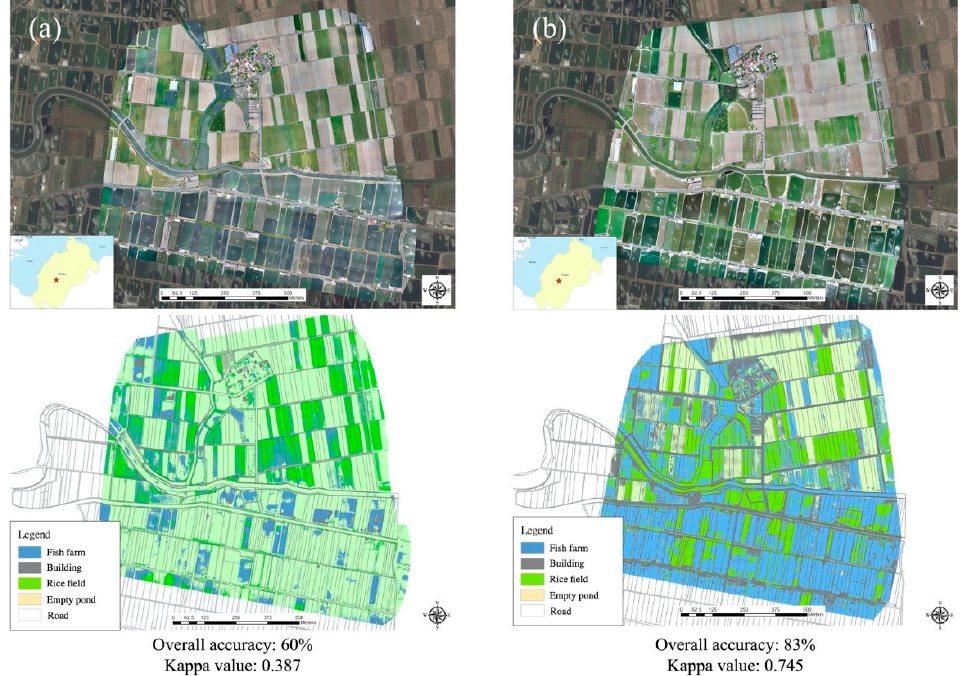
Figure 7. Interpretation accuracy at the Yizhu sampling site. The orthophoto captured on ( a ) 10 August 2018; ( b ) 21 September 2018.